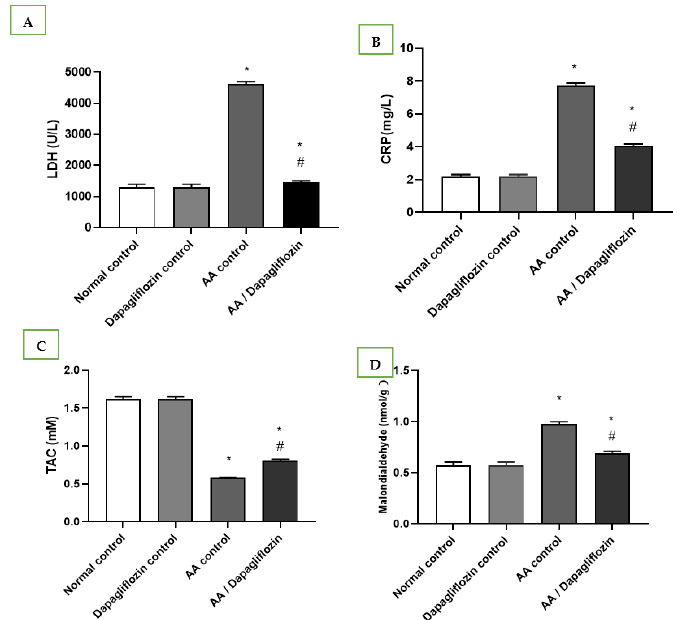
Figure 2. Effect of DAPA on AA-induced change in ( A ) serum Lactate dehydrogenase(LDH), ( B ) C-reactive protein(CRP), ( C ) Total antioxidant capcity(TAC), and ( D ) Malondialdehde(MDA). Data are expressed as mean ± SEM. Superscript characters reveal significant differences determined using one-way ANOVA followed by the Tukey–Kramer multiple comparison test (* p ˂ 0.05, DAPA significantly different from the normal control group; # p ˂ 0.05, DAPA significantly different from AA control group).